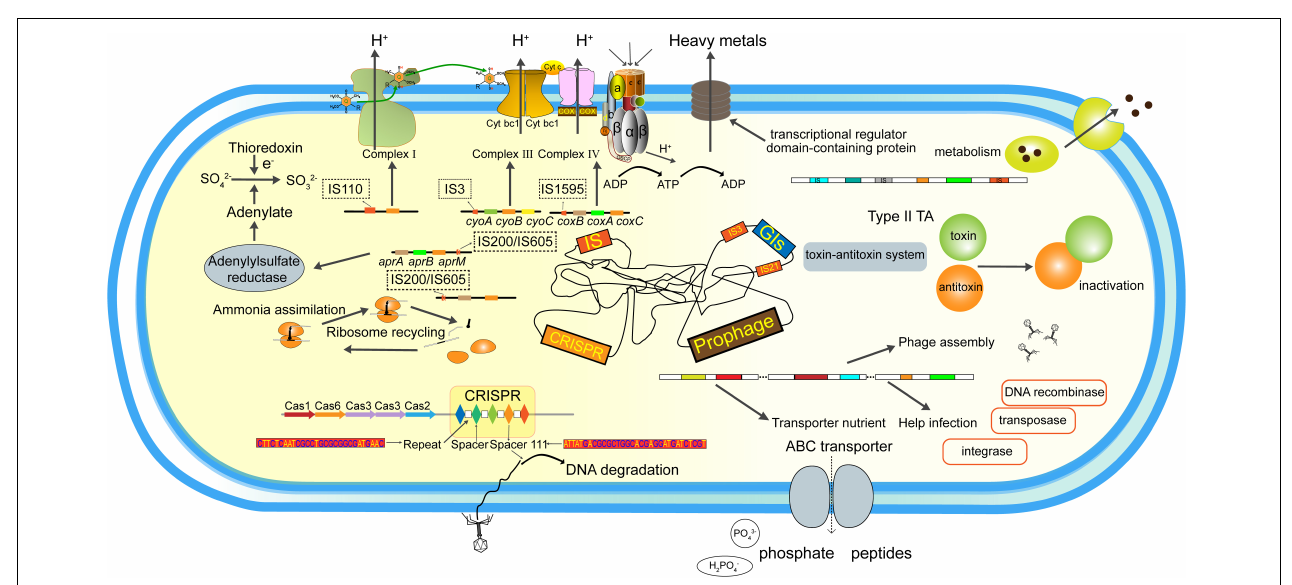
FIGURE 7 | A horizontal bar graph of the predicted proteins located on the GI regions (A) . GI distribution in Af. thiooxydans ZJ genome (B) . The blue and orange lines represent the GI predictions by IslandPath-DIMOB and SIGI-HMM, respectively, and the red line in the outer circle represents the comprehensive results by different methods. The peak map in the inner circle represents the variation of the GC content.